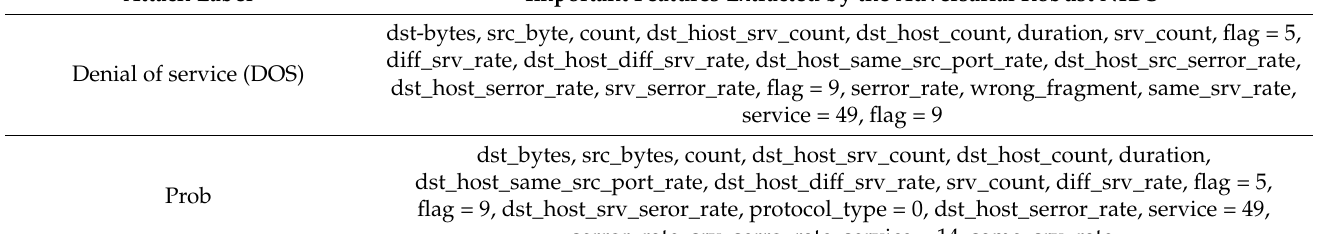
Table 9. A summary of the four attack types extracted by the adversarial robust NIDS. Important Features Extracted by the Adversarial Robust